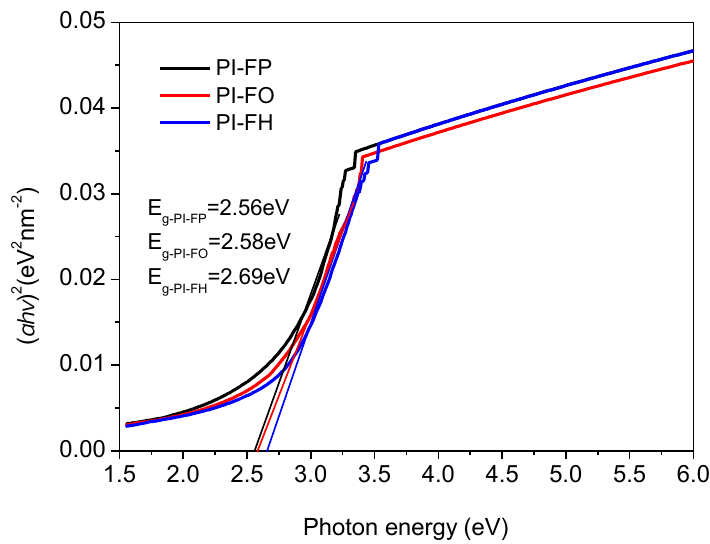
Figure 5. UV — VIS transmittance spectra of the PI films.